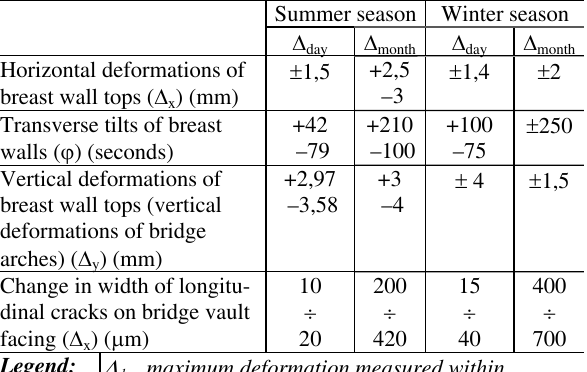
Table 1. Maximum values of one-day and one-month deforma- tions of the stone structure of Charles Bridge